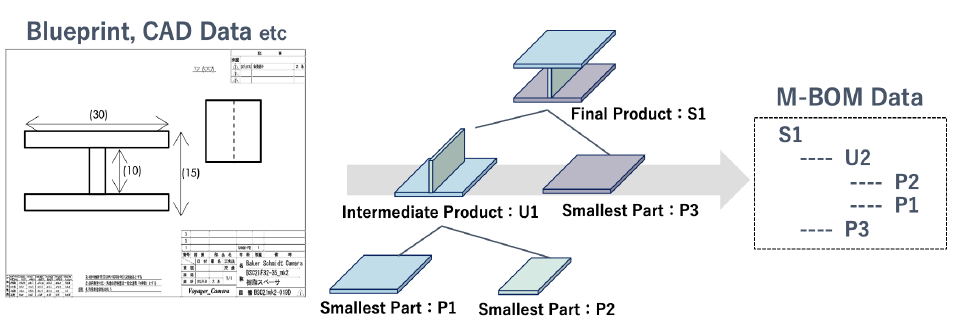
Figure 2. How to Create M-BOM Data.